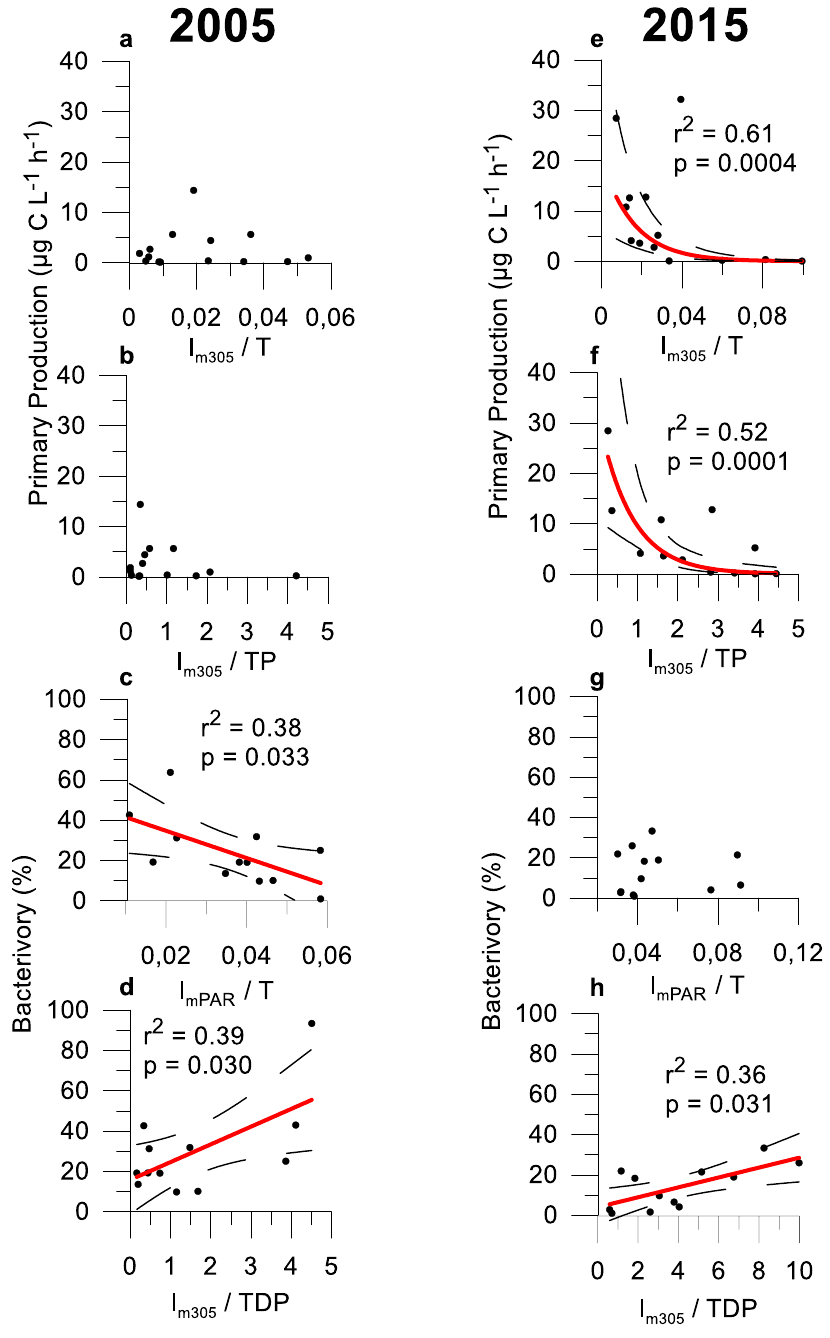
Figure 4. Response of PP P and BV rate to abiotic factors (I m305 :T, I m305 :Total P (TP), I mPAR :T and I m305 :Total dissolved P (TDP)) in Sierra Nevada Lakes in 2005 (left panel) and 2015 (right panel). Regression line, correlation coefficient (r 2 ) and p value are represented only for years with a significant